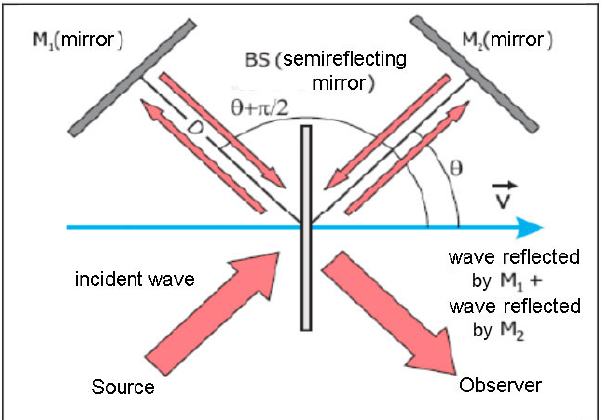
Figure 2. A schematic illustration of the Michelson interferometer. Note that, by computing the transit times and the resulting fringe shifts via Equation (50), we are assuming the validity of Lorentz transformations so that the length of a rod does not depend on its orientation, in the frame S (cid:48) , where it is at rest.